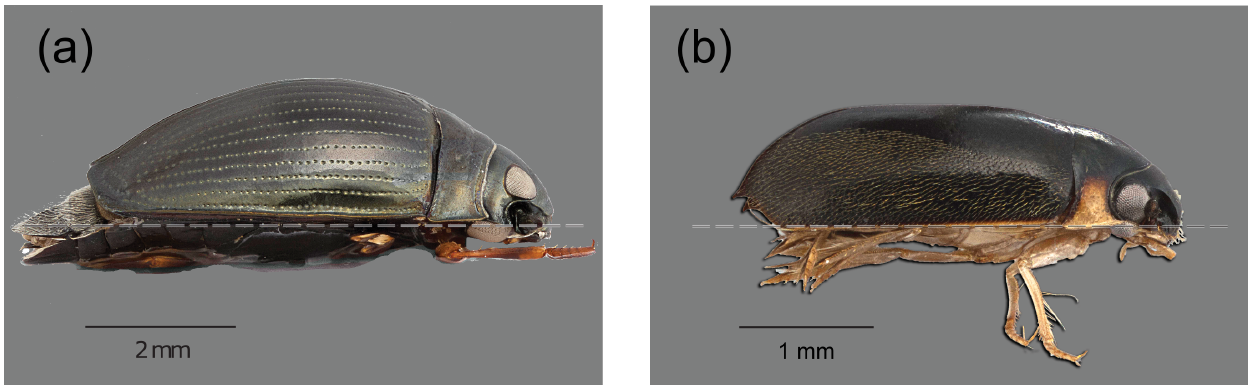
Figure 2. ( a ) Gyrinus dimorphus Régimbart deceased male in lateral view. Scale bar = 2 mm. ( b ) Spanglerogyrus albiventris Folkerts deceased male in lateral view. Scale bar = 1 mm. The dashed lines shows approximately where the water-line would sit on a living